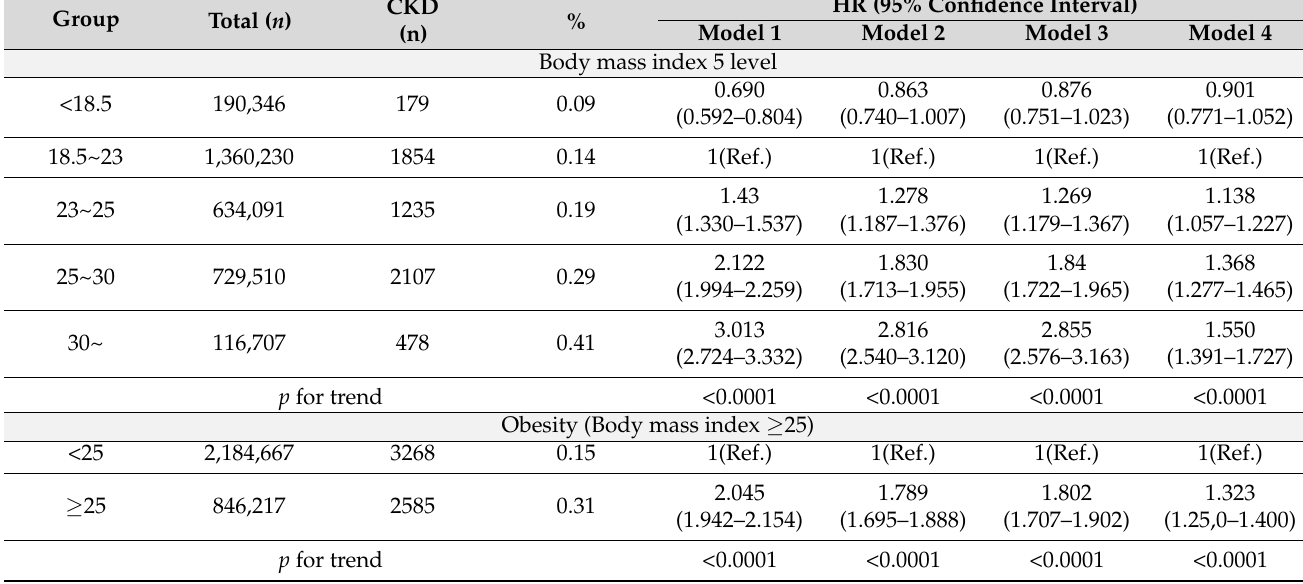
Figure 2. Odd ratios for chronic kidney disease according to body mass index ( A ) and waist circumference ( B ) in young adults. Adjusted for age, sex, low income (20%), diabetes mellitus, hypertension, dyslipidemia, current smoker, alcohol consumption, regular exercise, and eGFR. Table 4. Multivariate cox analysis for incident chronic kidney disease (CKD) by level of body mass index in young adults. Table 5. Multivariate cox analysis for incident CKD by level of waist circumference in young adults.